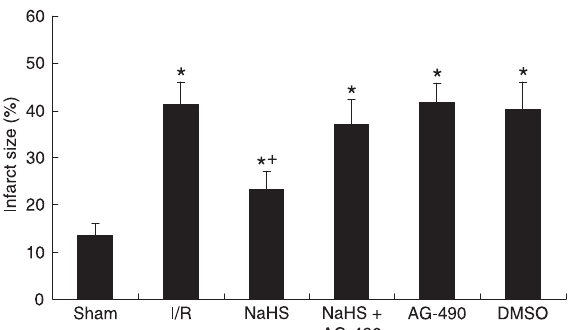
Figure 2. Percent infarct size of the myocardium at the end of rep- erfusion. Infarct size was determined using 1% triphenyltetrazolium chloride staining. Eight hearts were used in each group. Data are re- ported as means ± SD. *P < 0.05 vs Sham; + P < 0.05 vs I/R (one-way ANOVA). For abbreviations of groups, see legend to Figure 1.